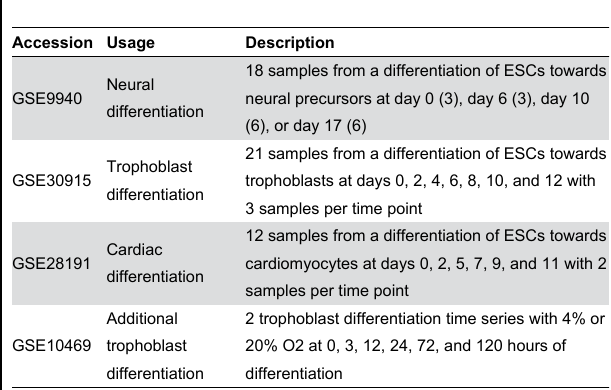
Table 4. Differentiation time series